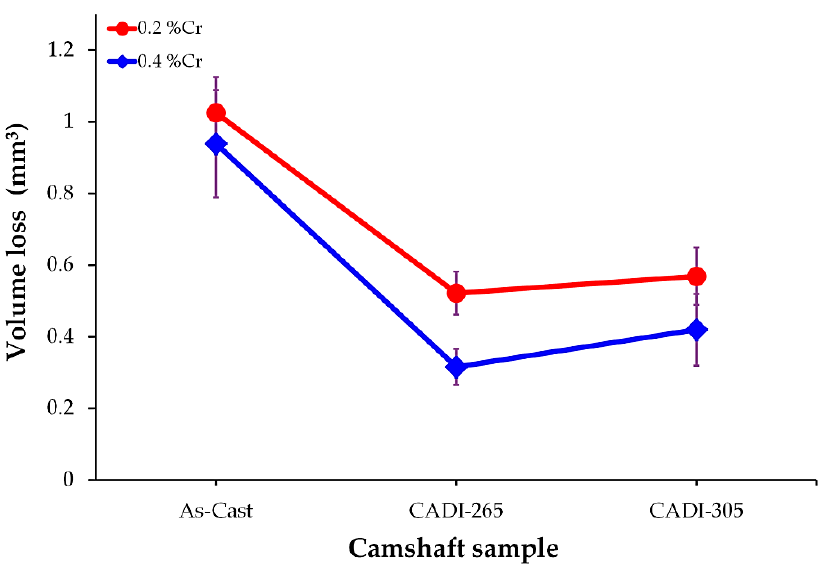
Figure 15. Effect of the austempering temperature and chromium content in the wear resistance for the CADIs evaluated.